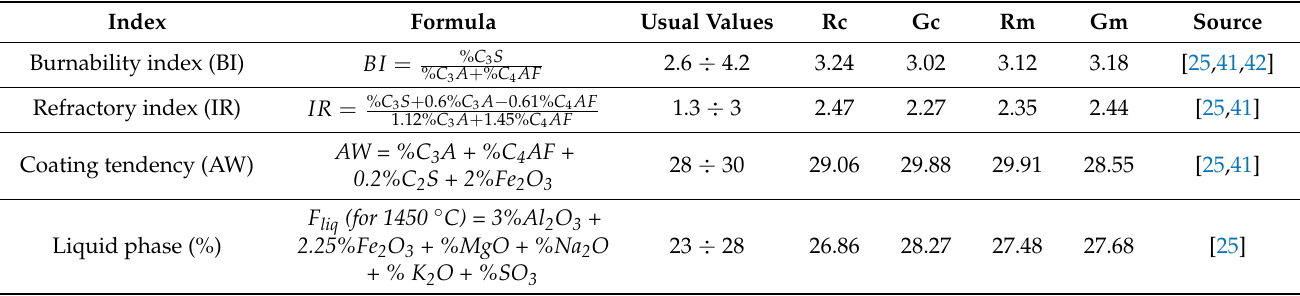
Table 3. Raw mix burnability indexes.